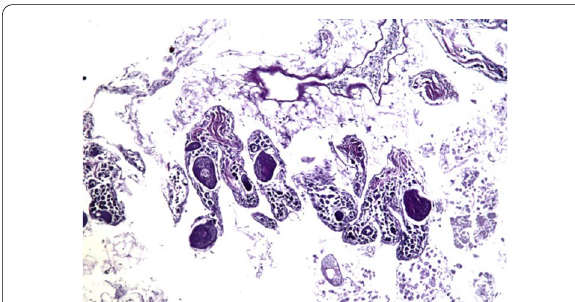
Fig. 1 Showed ovotestis of untreated M. vermiculata, different follicular and ova